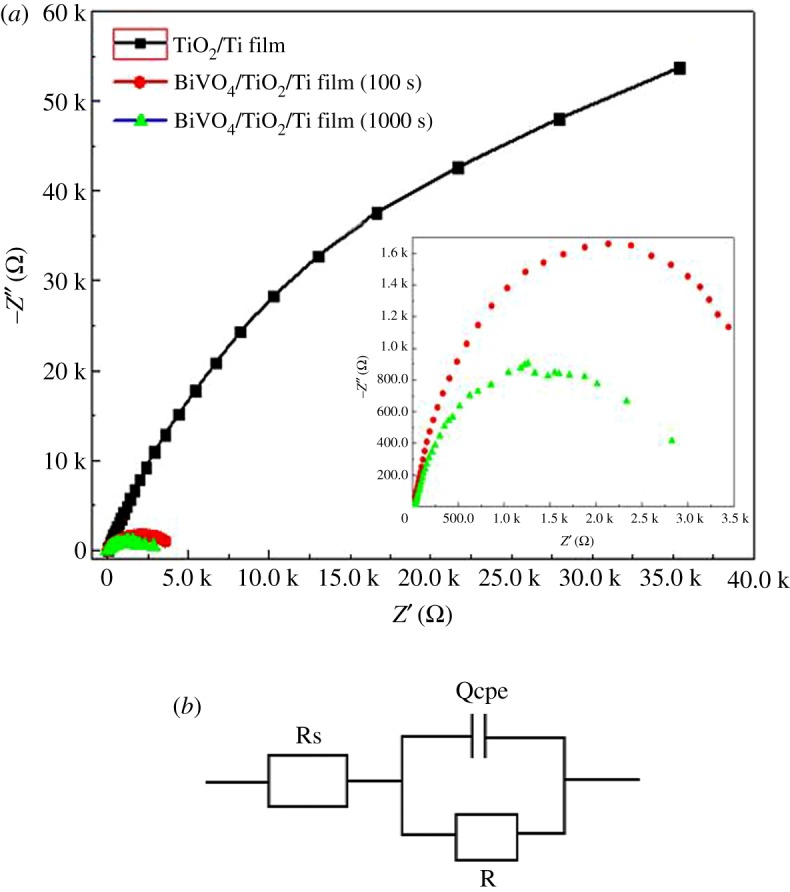
(a) EIS spectra of TiO2/Ti film and BiVO4/TiO2/Ti heterojunction film prepared with different electrodeposition times under 150 W Xe lamp illumination in 0.2 M Na2SO4 solution at 0.6 V versus SCE. (b) Equivalent circuit for photoanodes.